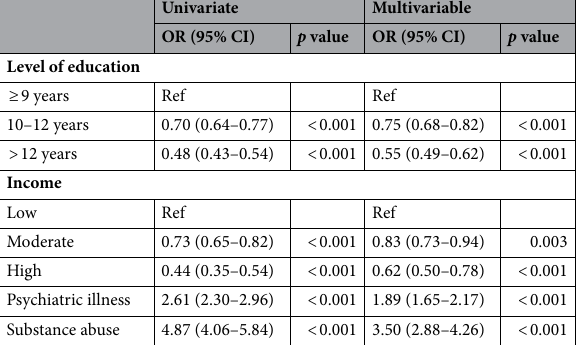
Table 4. Logistic regression analysis for the risk of community-acquired sepsis, patients with no somatic comorbidity. OR Odds ratio, CI Confidence interval.